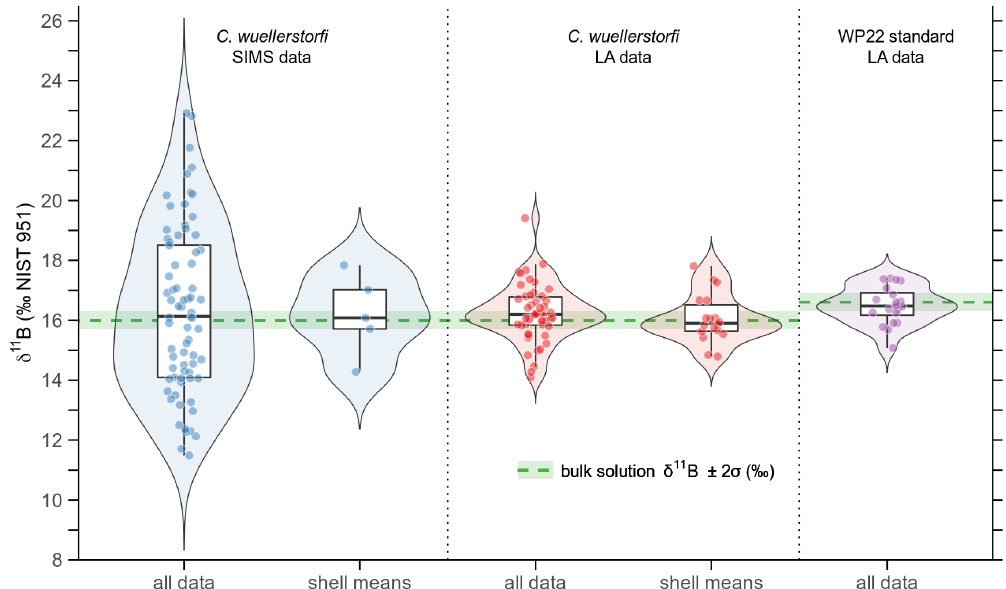
Figure 5. Violin, box and jitter plots showing the distribution of all single-site δ 11 B values and single-shell means, both for the SIMS and laser ablation techniques. For comparison, the distribution of δ 11 B values measured on the in-house reference material WP22 is displayed as well. The green dashed lines and bars represent the bulk solution δ 11 B ± 2 σ